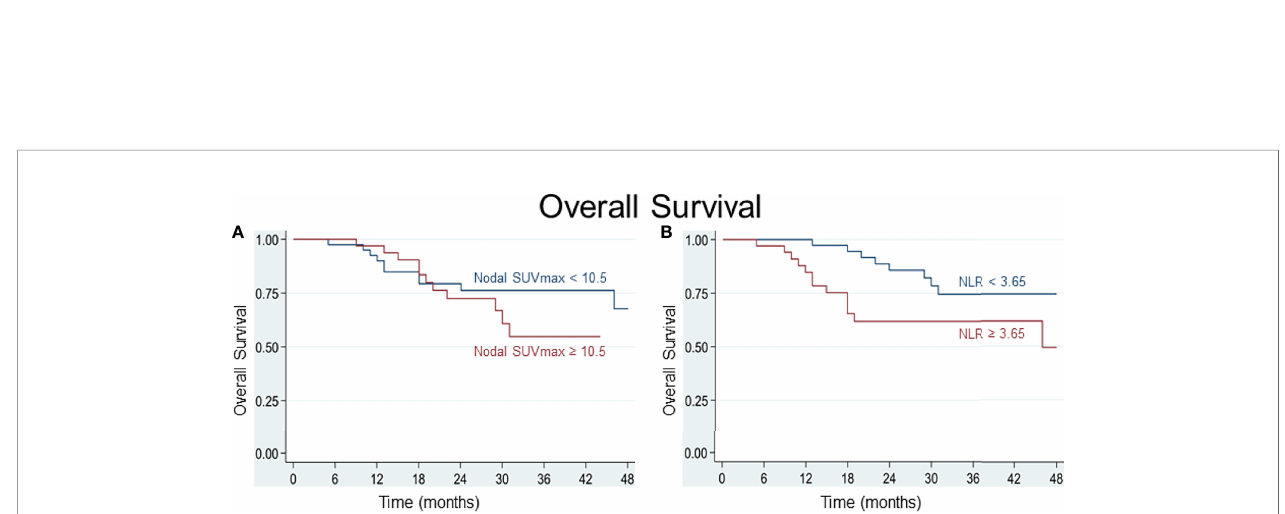
FIGURE 3 | Patients with a pretherapeutic SUV max of nodal metastasis ≥ 10.5 (A) and an NLR ≥ 3.75 (B) are at risk of worse disease-speci fi c survival.